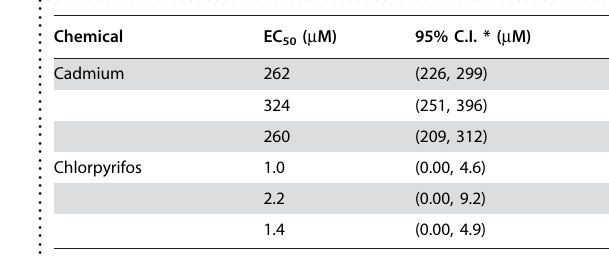
Table 2. Estimated EC 50 s and 95% maximum likelihood confidence intervals based on 3 repetitions of the C.